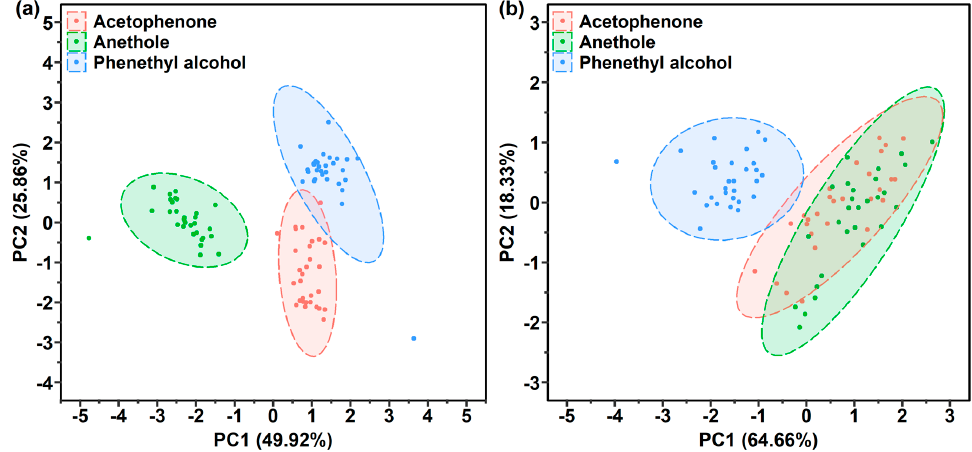
Figure 8. Comparison of PCA score plots of the ( a ) PDMS-coated and PAA-coated SERS gas sensors combination, and ( b ) one PDMS-PAA-coated SERS gas sensor used for the gas detection of phenethyl alcohol, acetophenone and